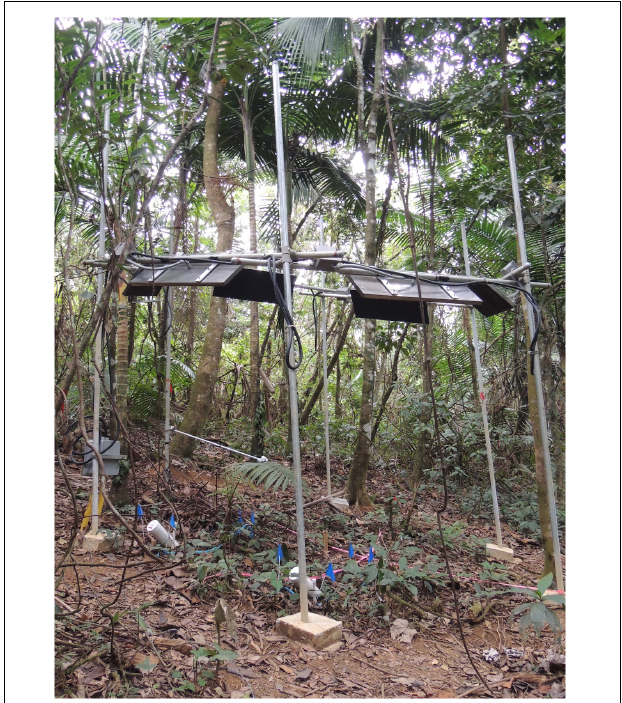
FIGURE 1 | Photograph of one of the experimental warming plots. Photo credit: Aura M. Alonso-Rodríguez.